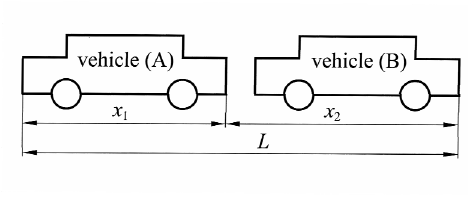
Fig 1. The “work done” analysis of colliding vehicles